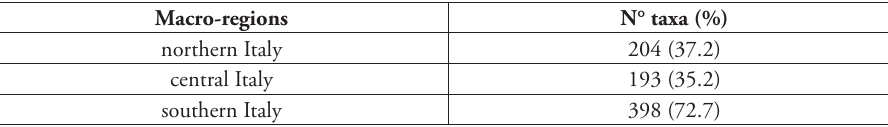
Table 2. Distribution of food taxa in Italian